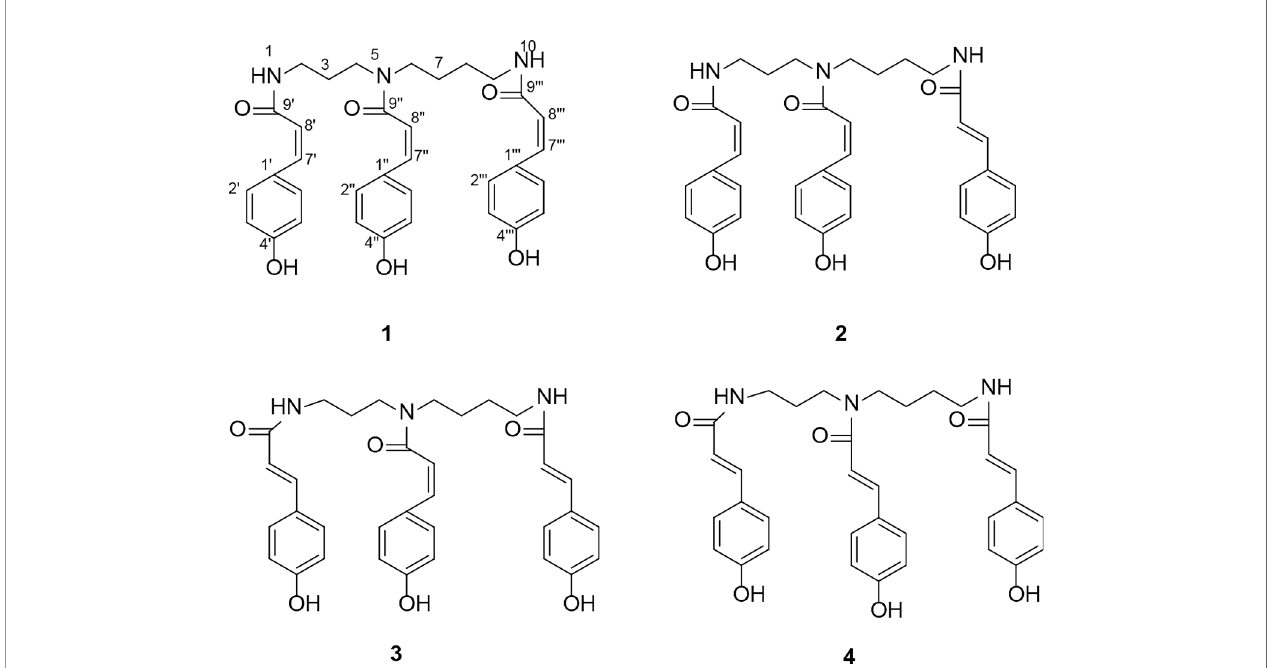
FIGURE 1 | The structure of four coumaroylspermidines in CSE. N1,N5,N10-( Z )-tri-p-coumaroylspermidine ( 1 ), N1,N5-( Z )-N10-( E )-tri-p-coumaroylspermidine ( 2 ), N1- ( E )-N5-( Z )-N10-( E )-tri-p-coumaroylspermidine ( 3 ), and N1,N5,N10-( E )-tri-p-coumaroylspermidine ( 4